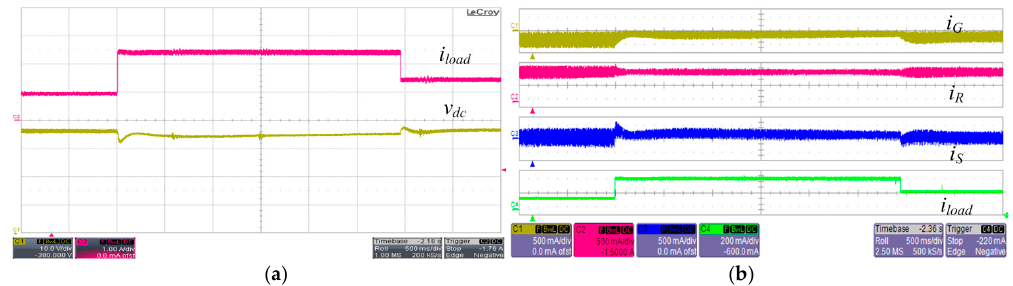
Figure 11. Experimental waveforms of load step change on State 111 (0.4 kW to 1 kW to 0.6 kW). ( a ) Load current and dc bus voltage; and ( b ) output current.